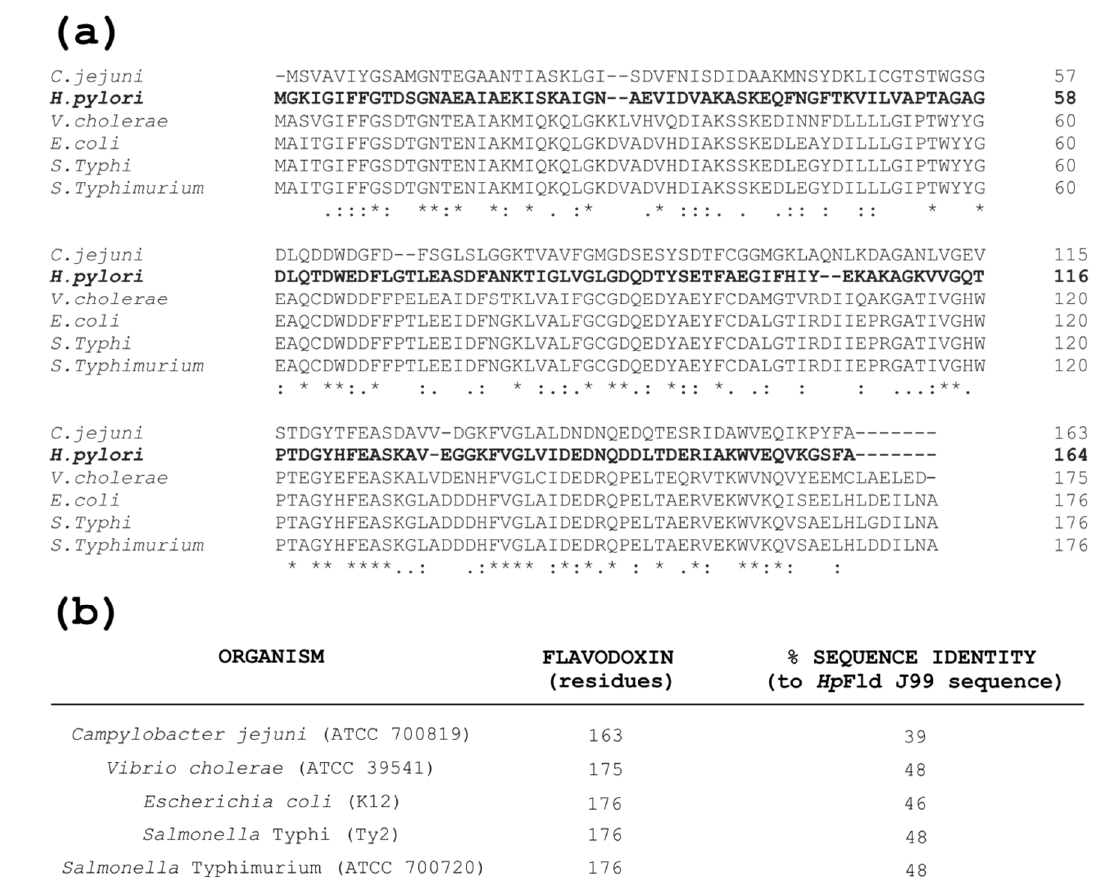
Figure A2. ( a ) Multiple sequence alignment of flavodoxins from Campylobacter jejuni (strain ATCC 700819), Hp (strain J99), Vibrio cholerae (strain ATCC 39541), Escherichia coli (strain K12), Salmonella enterica subsp. enterica serovar Typhi (strain Ty2) and Salmonella enterica subsp. enterica serovar Typhimurium (strain ATCC 700720). It has been performed with Clustal Omega [194]. ( b ) Sequence identity between Hp (strain J99) flavodoxin and that from Campylobacter jejuni (strain ATCC 700819), Vibrio cholerae (strain ATCC 39541), Escherichia coli (strain K12), Salmonella enterica subsp. enterica serovar Typhi (strain Ty2), and Salmonellaenterica subsp. enterica serovar Typhimurium (strain ATCC 700720). It has been calculated with Clustal Omega [194].